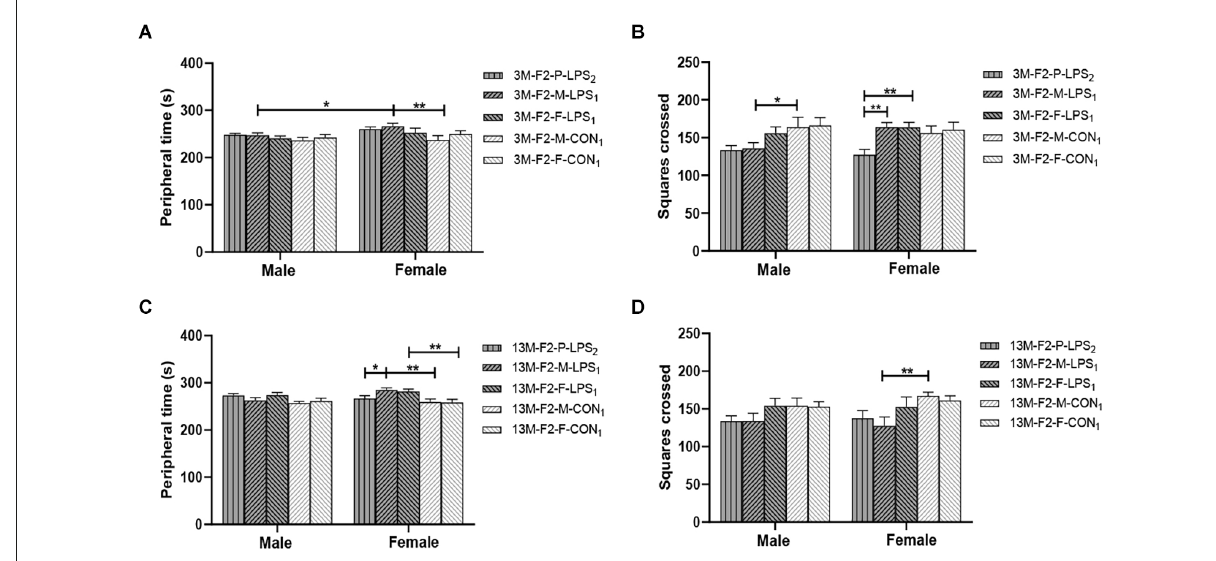
FIGURE3 Results of the open field test in the F2 generation. (A,C) Peripheral time, (B,D) number of squares crossed in the 3-month-old (3 M) and 13- month-old (13 M) CD-1 mice in different groups. n = 10 male or female mice/group. Error bars = standard error of the mean (SEM). * P < 0.05, ** P < 0.01; F2-M-LPS 1 , mice whose mothers were exposed to prenatal inflammation; F2-P-LPS 2 , mice whose parents were exposed to prenatal inflammation; F2-F-LPS 1 , mice whose fathers were exposed to prenatal inflammation; F2-M-CON 1 , mice whose mothers were exposed to saline in utero ; F2-F-CON 1 , mice whose fathers were exposed to saline in utero